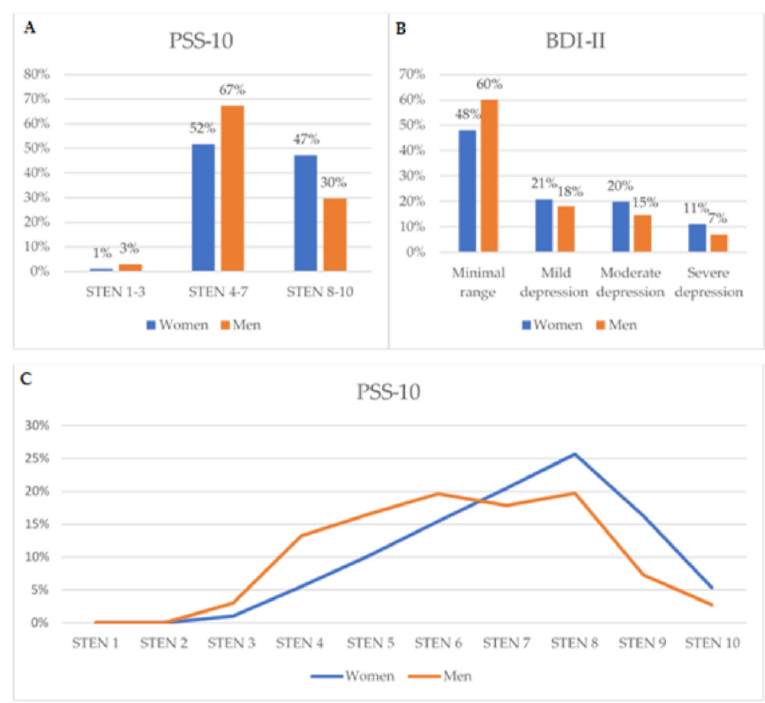
Figure 1. Percentage distribution of participants in the specified cutoffs for PSS-10 ( A , C ) and BDI-II ( B ).